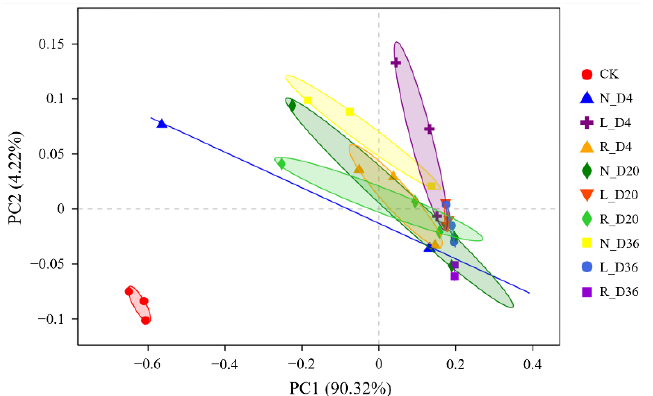
Figure 4. PCoA based on operational taxonomic units (OTUs) of the bacterial community in samples of the fermented sausages. CK: initial fermented sausages (unfermented), N: fermented sausages with 3% NaCl (reference), L: fermented sausages with 2.25% NaCl (25% reduction), R: fermented sausages with partial replacement of 25% NaCl. The marks D4, D20 and D36 represent the fermentation and ripening times (days).